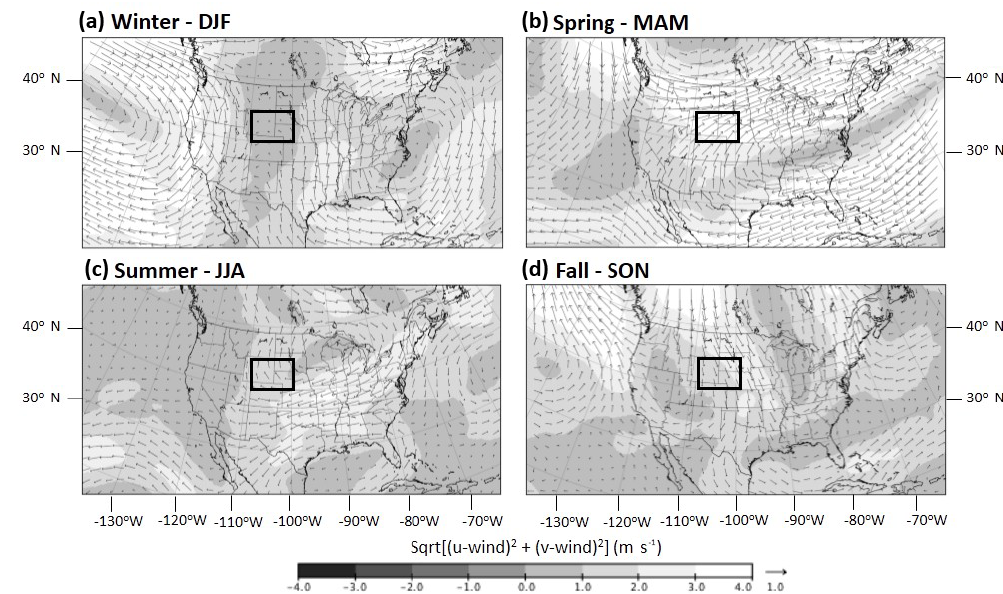
Figure 8. Seasonal composite-anomaly maps for 500mbar vector winds during (a) winter (DJF); (b) spring (MAM); (c) summer (JJA); and (d) fall (SON). The black box denotes the study